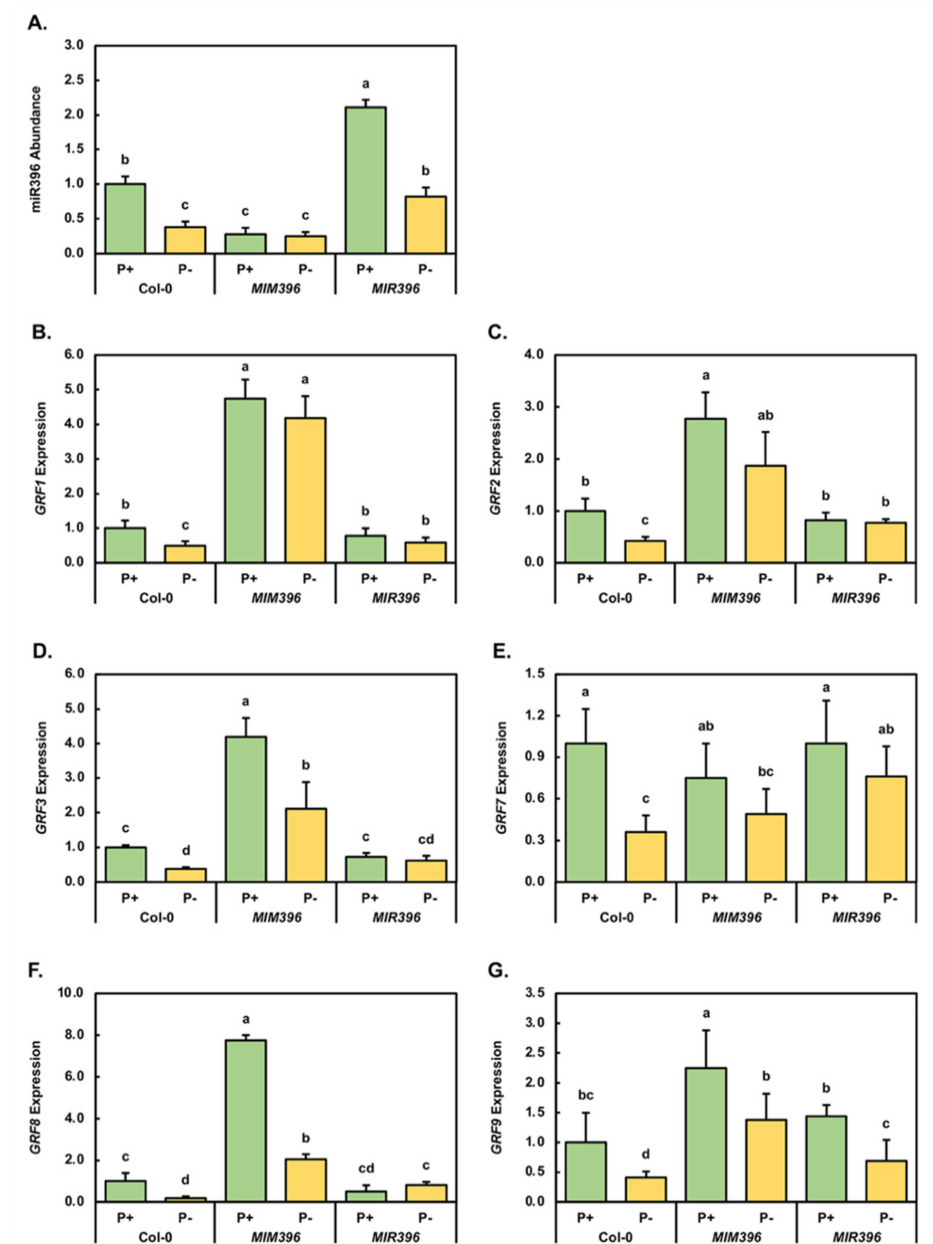
Figure 3. Molecular profiling of the miR396/ GRF expression module in 15-day-old control-grown and PO 4 -starved Col-0, MIM396 and MIR396 seedlings. ( A ) Quantification of miR396 abundance by RT-qPCR in control-grown (P + ) and PO 4 -starved (P - ) Col-0, MIM396 and MIR396 plants. RT-qPCR quantification of the expression of the six members of the Arabidopsis GRF gene family targeted by miR396 for expression regulation, including GRF1 ( B ), GRF2 ( C ), GRF3 ( D ), GRF7 ( E ), GRF8 ( F ) and GRF9 ( G ), in the Col-0/P + , Col-0/P - , MIM396 /P + , MIM396 /P - , MIR396 /P + and MIR396 /P - samples. ( A – G ) Error bars represent the standard deviation of four biological replicates. All statistical data were analyzed via the use of the one-way ANOVA and Tukey’s post hoc tests. A statistically significant difference ( p -value < 0.05) is represented by a different letter above a histogram